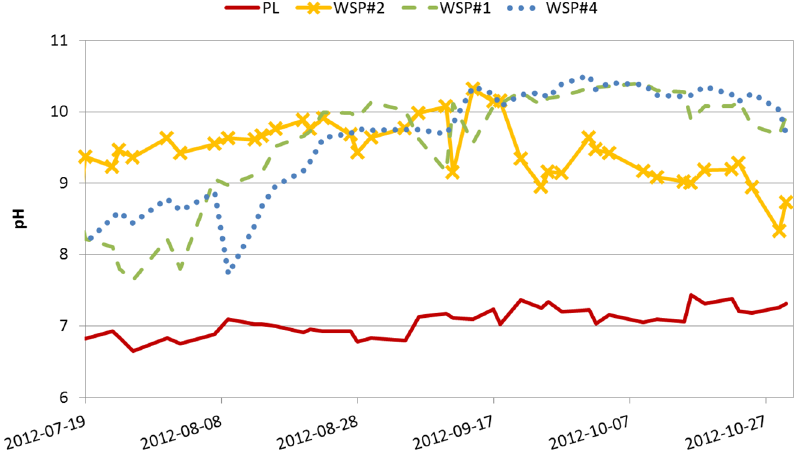
Figure 5. pH levels in the Amherstview WPCP WSPs over the July to September 2012 sampling period, showing high pH increases in WSP#2 that remain high through WSP#1 and